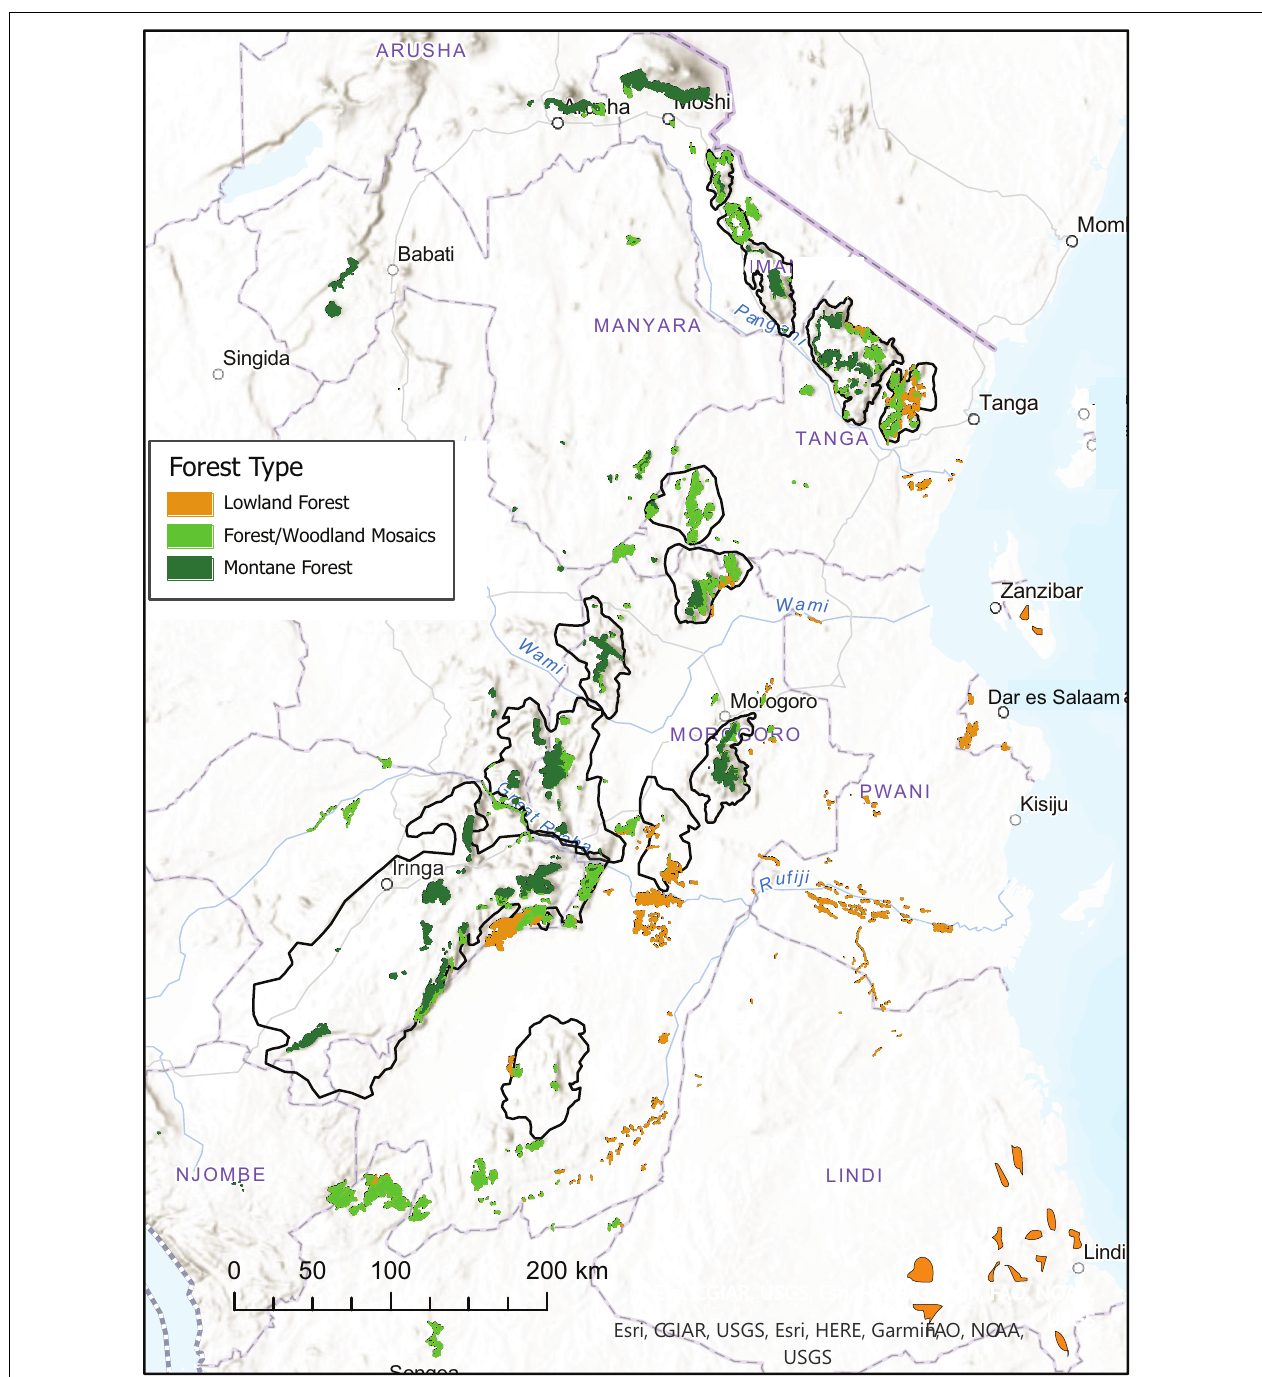
FIGURE 1 | Map of montane and lowland forest fragments distributed across eastern Africa. Black polygons demarcate the boundaries of the Eastern Arc Mountains of Tanzania (see Figure 7 ). Data compiled as part of the CMEAMF baseline report [Forestry and Beekeeping Division (2006)].